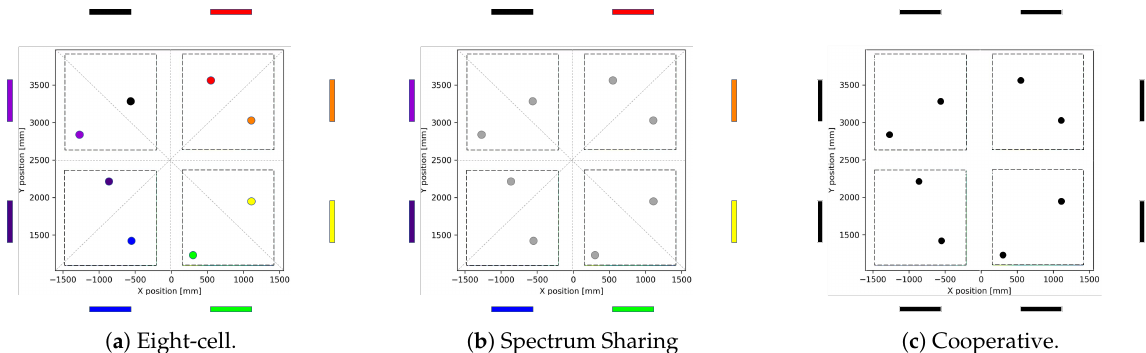
Figure 5. Three MIMO scenarios under different levels of cooperation. ( a ) Eight independent cells (different array and user colours) working in different frequency bands. ( b ) Eight cells sharing the same frequency band. ( c ) Eight fully synchronised cells that share spectrum and infrastructure.